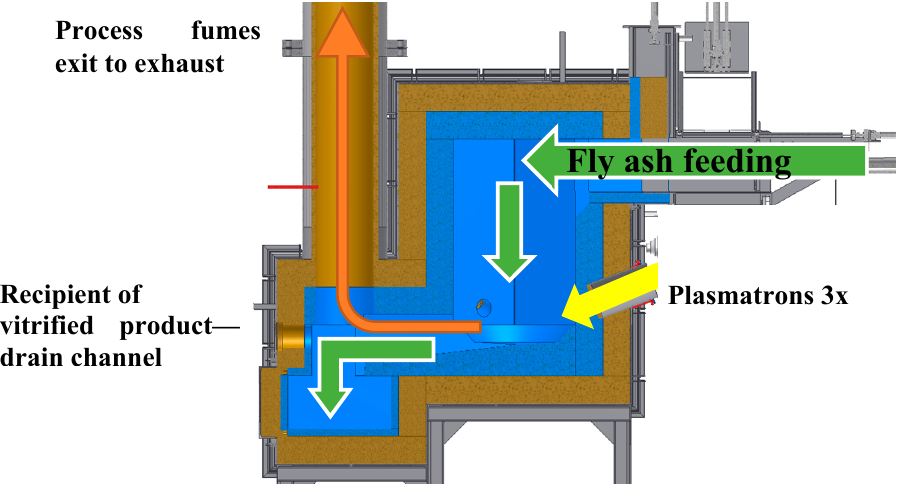
Figure 3. Cut through plasma reactor. Arrows indicate the material, fumes, and plasma flow.